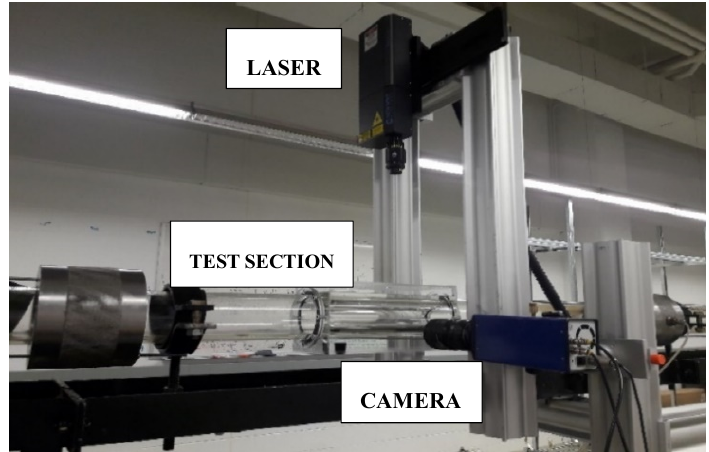
Figure 3. Image of the particle image velocimetry (PIV) setup and the test section.